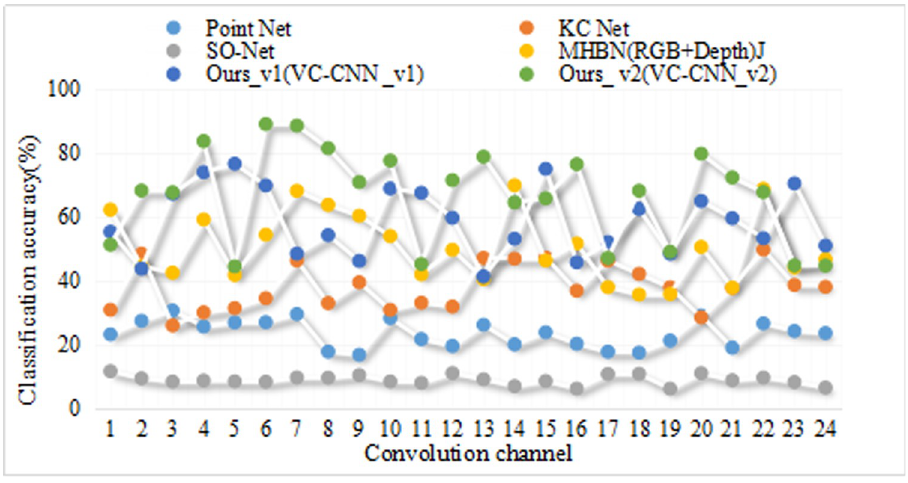
Fig 13. The efficiency of logistics